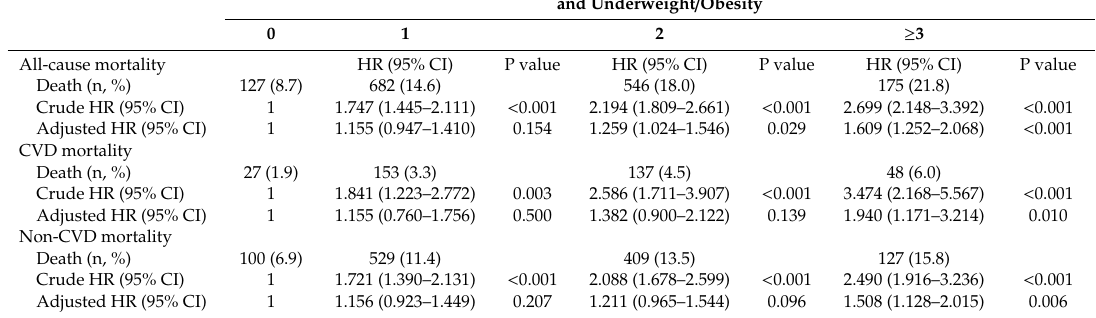
Table 4. The risks of all cause- and cardiovascular disease-mortality according to a number of lifestyle risk factors.